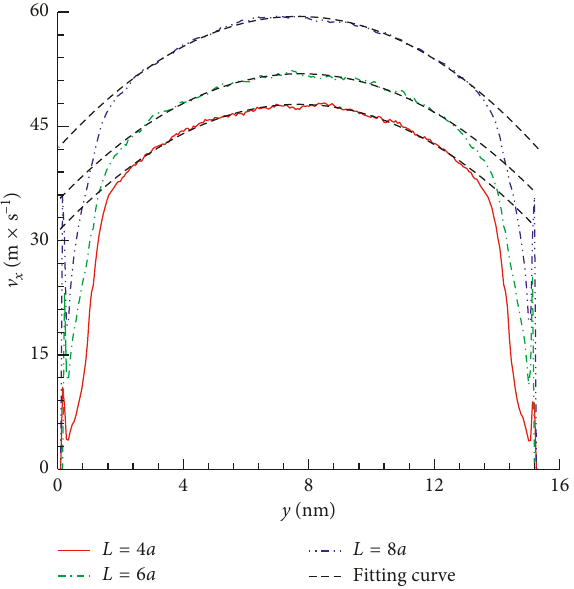
Figure 7: Velocity profiles at different roughness element